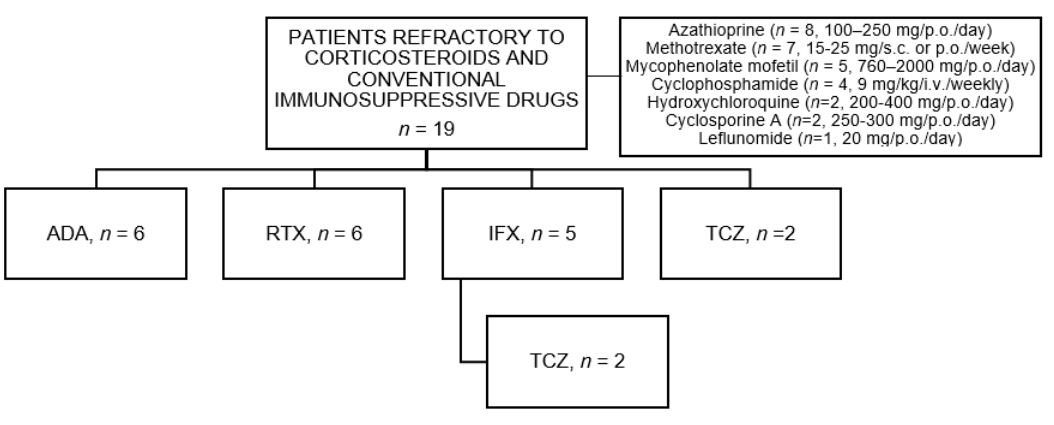
Figure 1. Flow-chart of biologic therapy in refractory non-Multiple Sclerosis optic neuritis. Abbreviations: ADA: Adalimumab, IFX: Infliximab; IS: Immunosuppressive, RTX: Rituximab; TCZ: